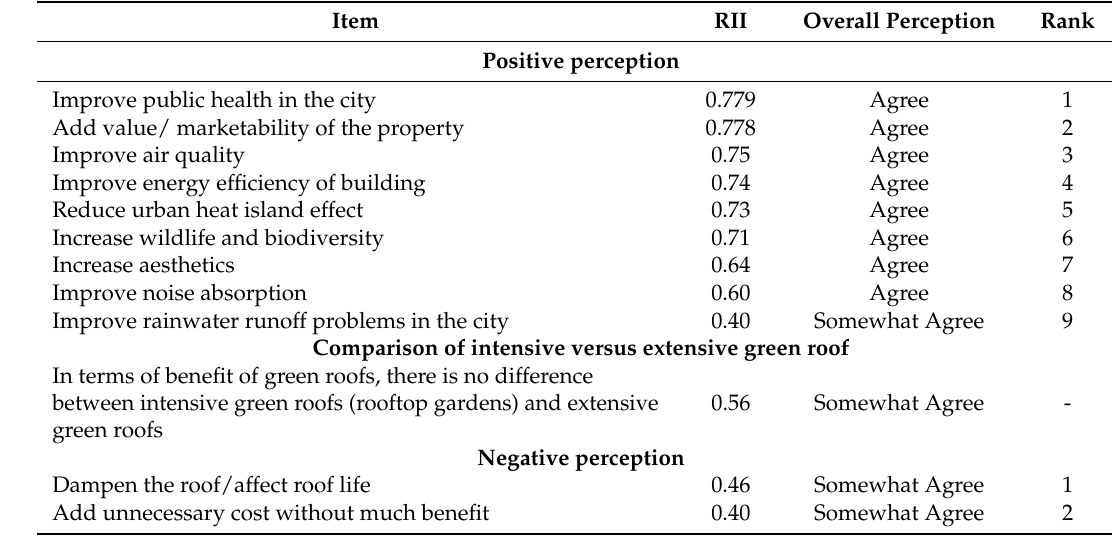
Table 5. General perception about green